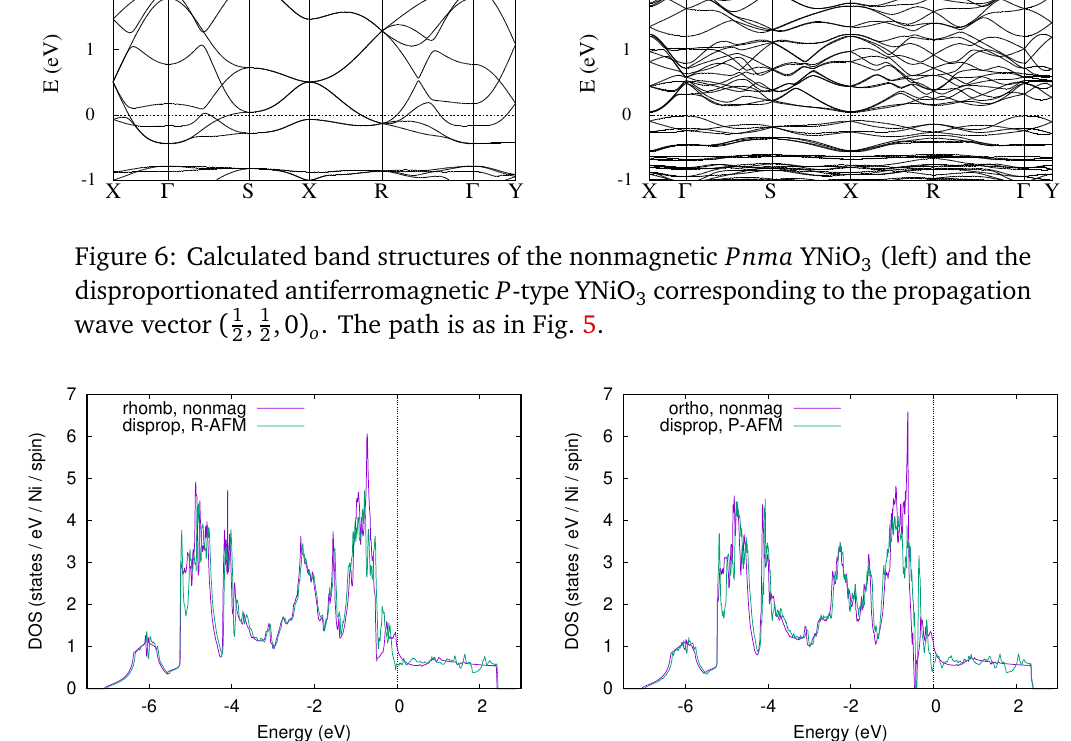
in the rhombohedral non- 3